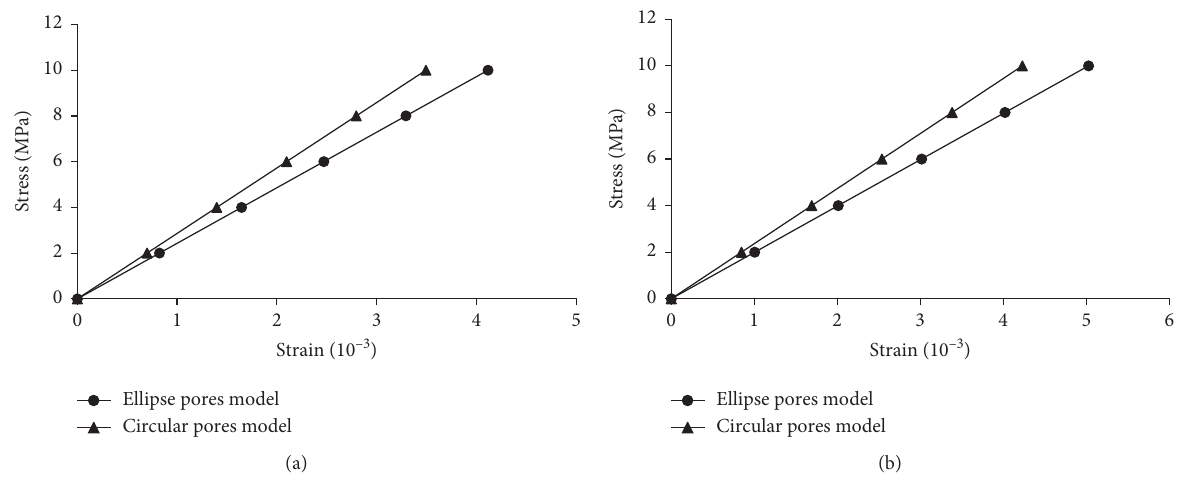
Figure 14: Effect of pores shape on the simulation results: (a) specimen 1#; (b) specimen 2#.